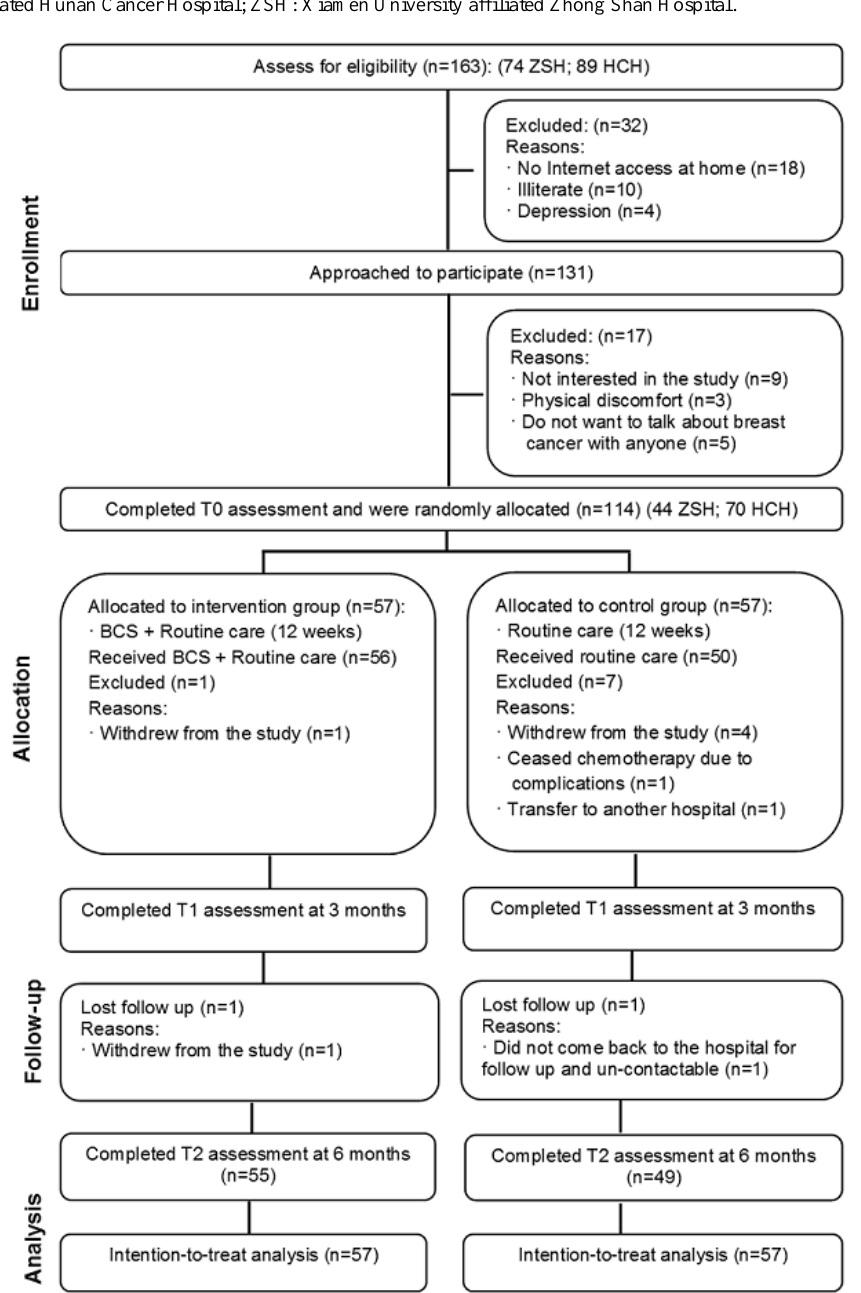
Figure 2. Consolidated Standard of Reporting Trials (CONSORT) diagram of Breast Cancer e-Support program (BCS) program. HCH: Central South University affiliated Hunan Cancer Hospital; ZSH: Xiamen University affiliated Zhong Shan